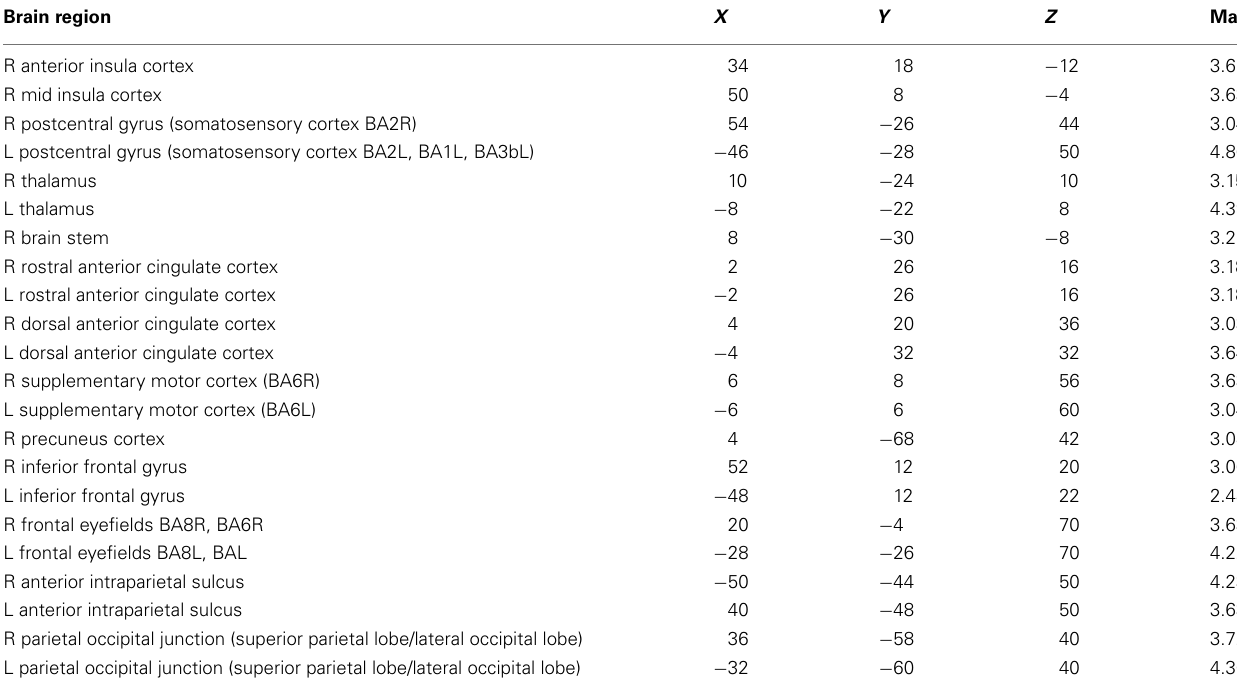
TableA1 | Complete list of brain regions showing significant BOLD activation during aware errors as compared to unaware errors. Brain